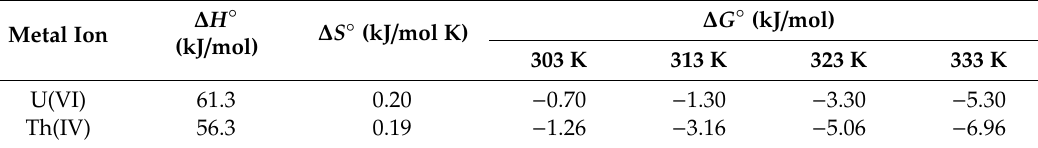
Figure 15. Variation of ln K D with 1 / T for sorption of U(VI) and Th(IV) onto HQ-bentonite. Table 4. Values of thermodynamic parameters of U(VI) and Th(IV) ions sorption onto HQ-bentonite.